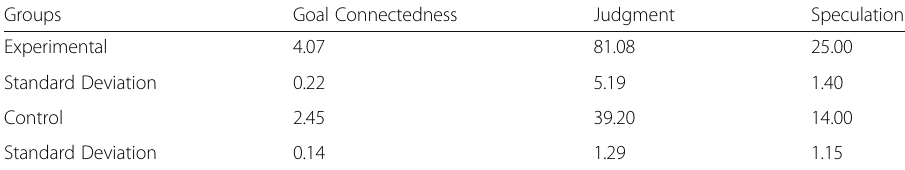
Table 6 Measures obtained by both groups Groups Goal